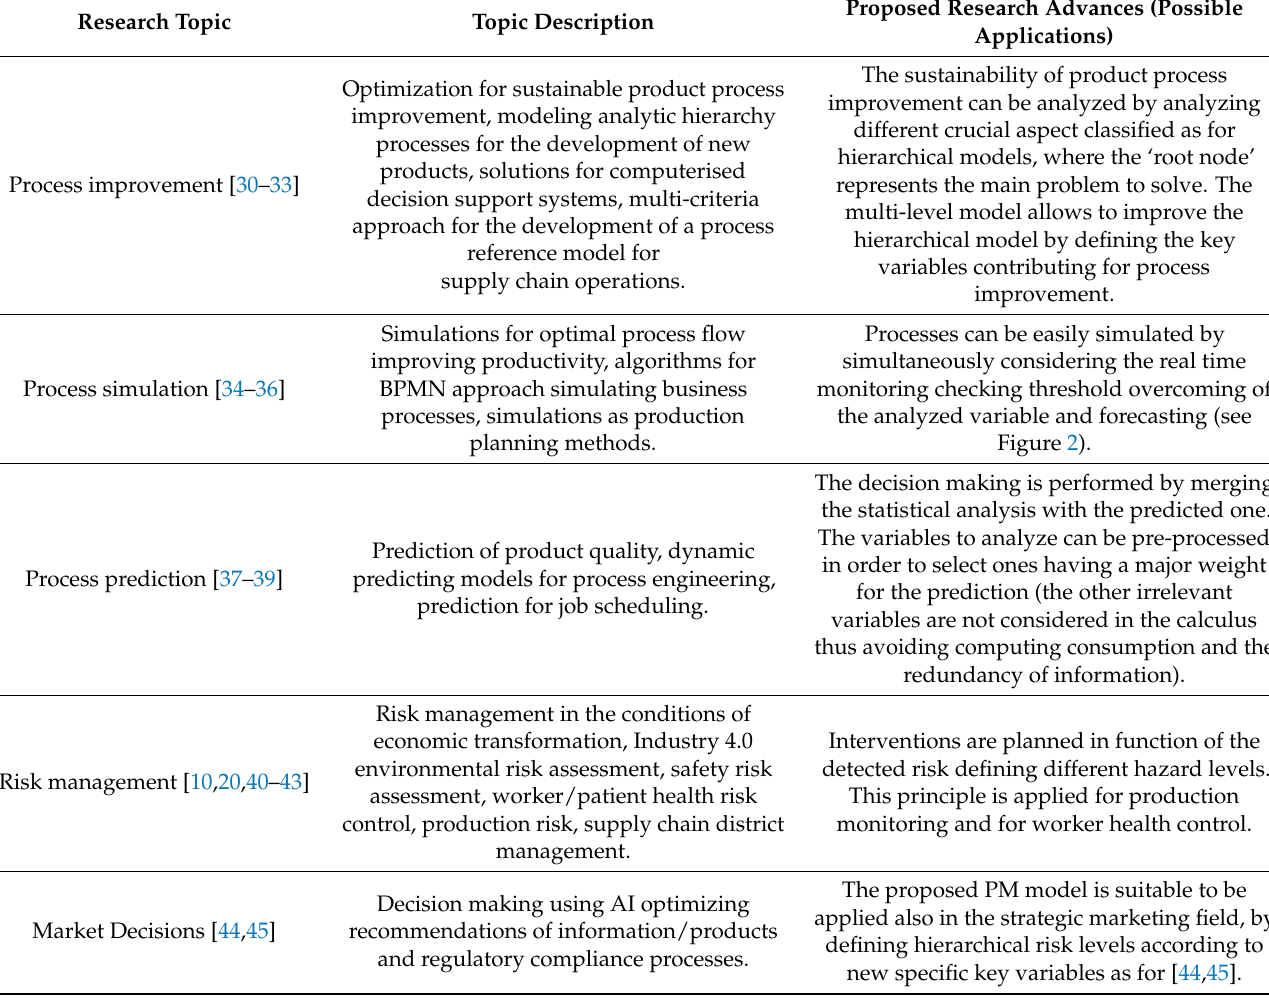
Table 4. Literature and research gap concerning main research topics involving